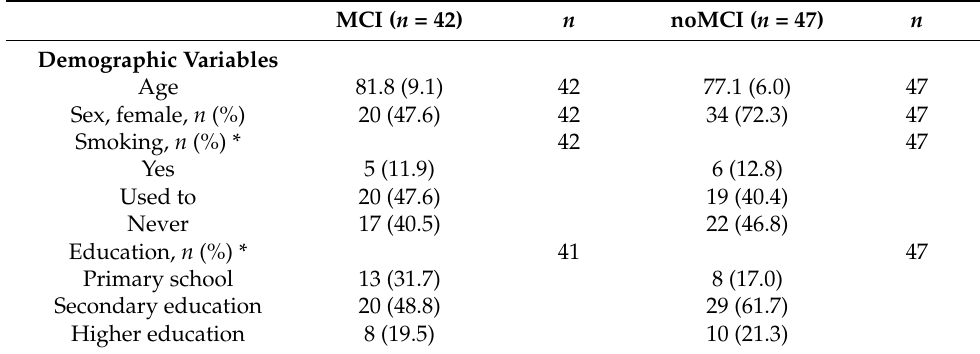
Table 1. Characteristics of the study participants at 4-week follow-up ( n = 89).